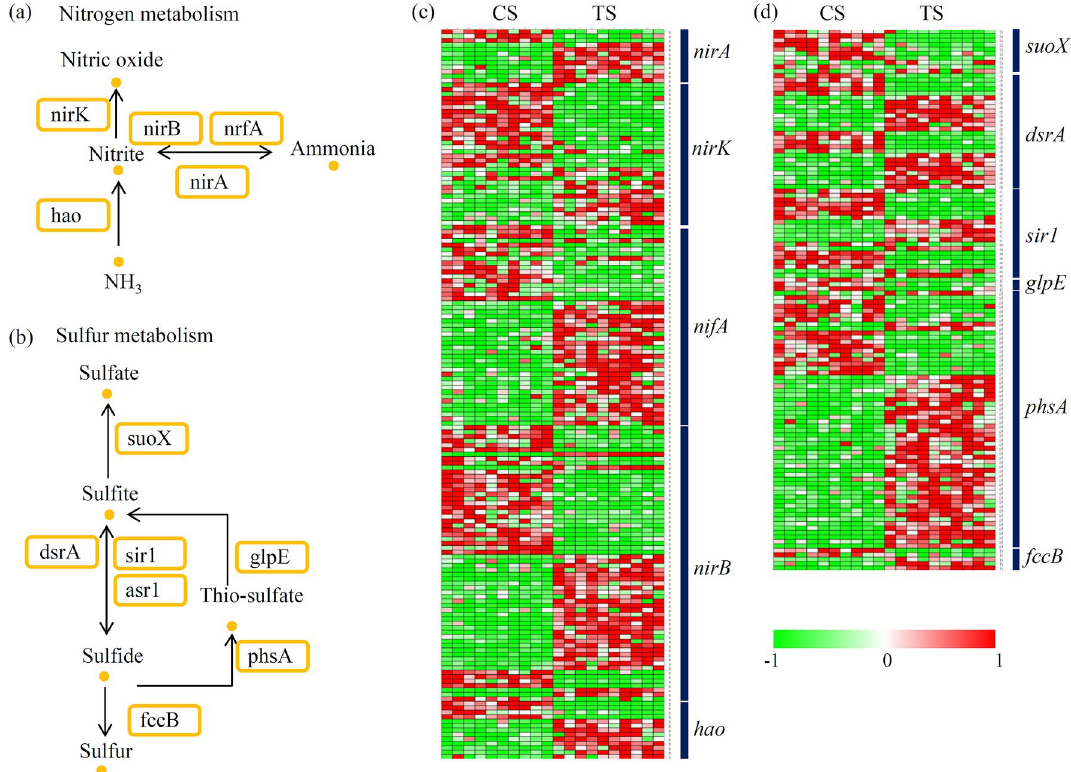
Figure 4. Analysis of the genes involved in the nitrogen metabolic and sulfur metabolic pathways. ( a ) Overview of the nitrogen metabolic pathway. ( b ) Overview of the sulfur metabolic pathway. ( c ) The relative abundances of the genes involved in the nitrogen metabolic pathway. ( b ) The relative abundances of the genes involved in the sulfur metabolic pathway. Red indicated low abundance and green indicated high abundance of each gene. The heatmap scale ranges from − 1 to + 1 on a log 2